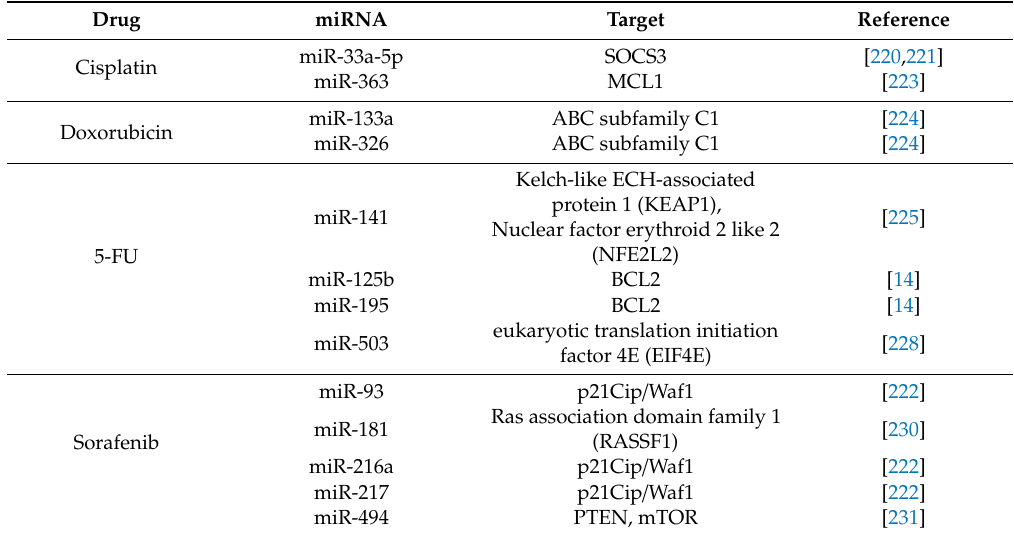
Table 5. Recently reported miRNAs in HCC therapy